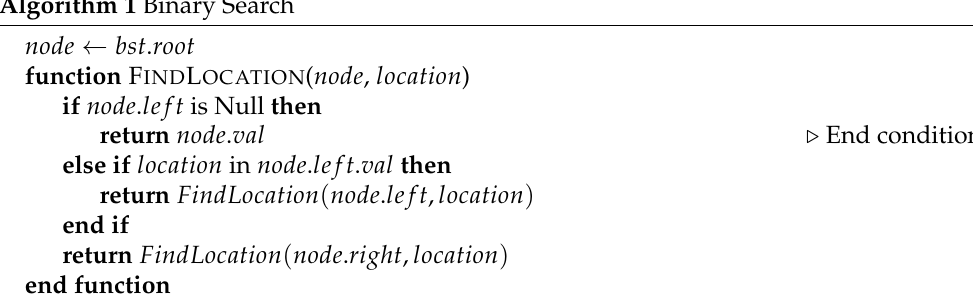
Algorithm 1 Binary